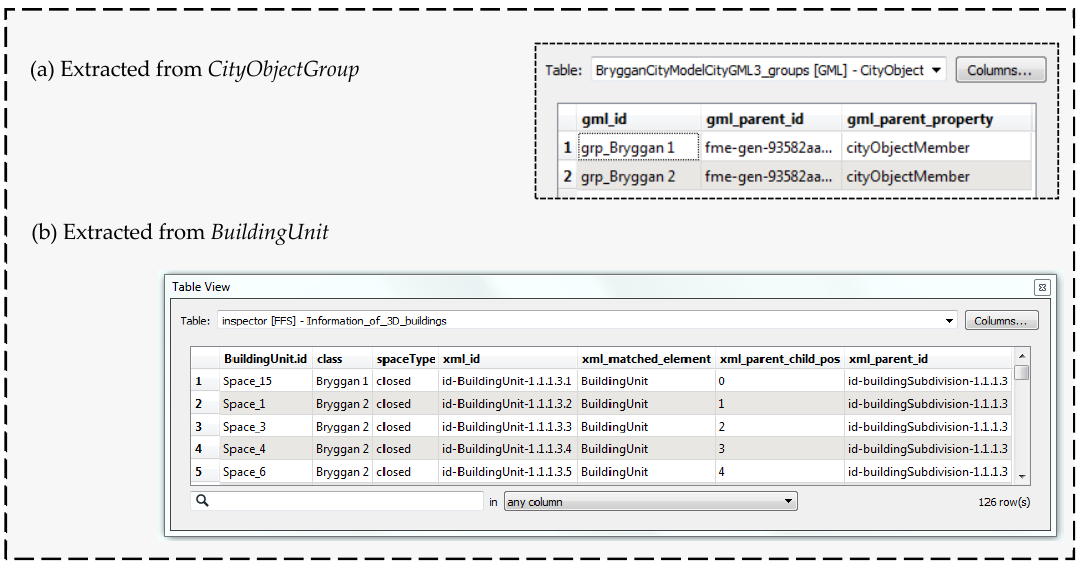
Figure 18. Attribute information extracted from different feature types in CityGML 3.0.